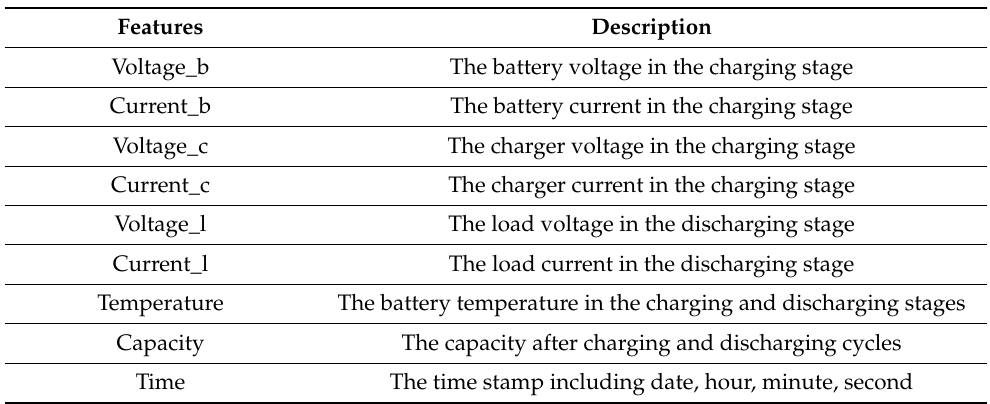
Table 2. Features of battery charging and discharging